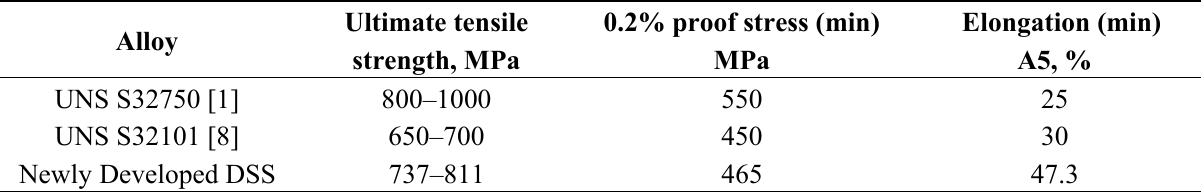
Table 3. Typical values of mechanical properties of solution annealed duplex stainless steels (DSS).